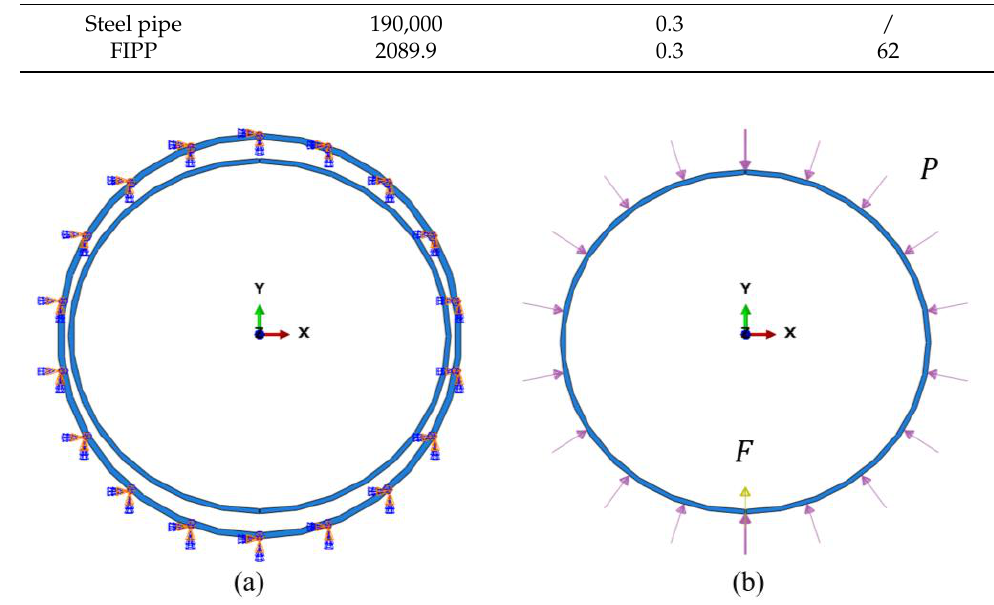
Figure 3. The condition of ( a ) boundary and ( b ) load